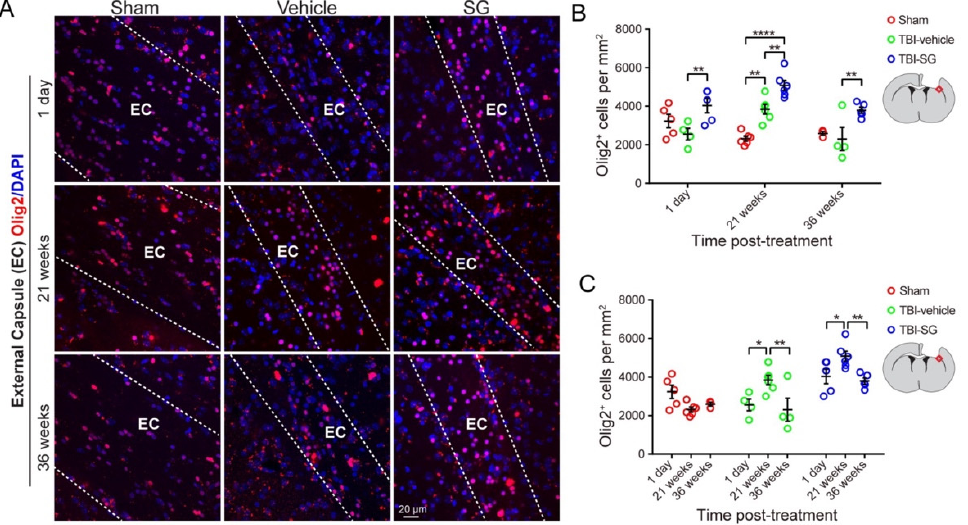
Figure 4. SCF + G-CSF treatment increases Olig2-immunopositive cells in the ipsilateral external capsule in the chronic phase of severe TBI. ( A ) Representative images of Olig2-immunopositive oligodendrocyte progenitor cells and oligodendrocytes in the ipsilateral external capsule (EC, between two dashed lines) at 1 day, 21 weeks, and 36 weeks post-treatment. ( B ) Quantitative data of analysis of the Olig2-immunopositive cells in the ipsilateral external capsule at 1 day, 21 weeks, and 36 weeks post-treatment in the sham, TBI-vehicle, and TBI-SCF+G-CSF groups. ( C ) Quantitative data of analysis of the Olig2-immunopositive cells in the ipsilateral external capsule in the sham, TBI-vehicle, and TBI-SCF+G-CSF groups at different time points. Two-way ANOVA followed by Tukey post hoc test . * p < 0.05, ** p < 0.01, **** p < 0.0001. Scale bar: 20 µm. SG: SCF+G-CSF.